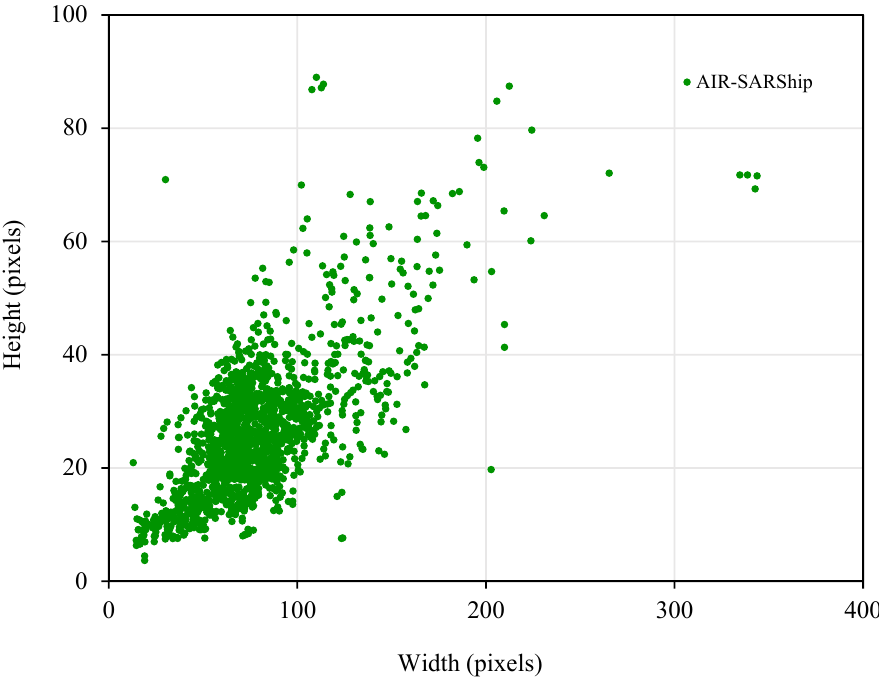
Figure 3. Distribution of ship size on AIR-SARShip.